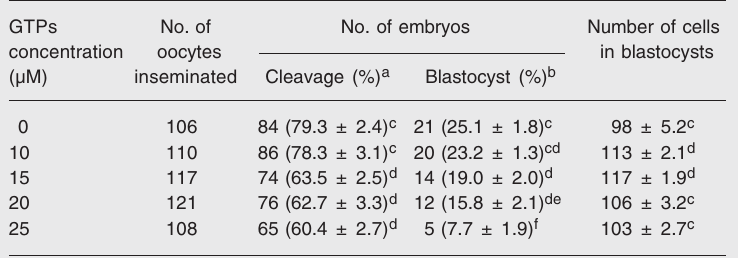
a Number of embryos is reported as median and percent of embryos cleaved as percent of the number of inseminated oocytes (mean ± SEM), or b percent of blasto- cysts as percent of the number of cleaved embryos (mean ± SEM). c,d,e Values with different superscripts within a column are significantly different from each other (P < 0.05, ANOVA followed by the Fisher protected least significant difference test).